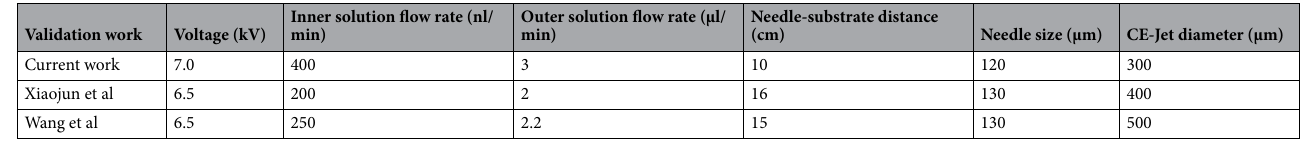
Table 4. Comparison of results at different optimized parameters during CE-Jet printing